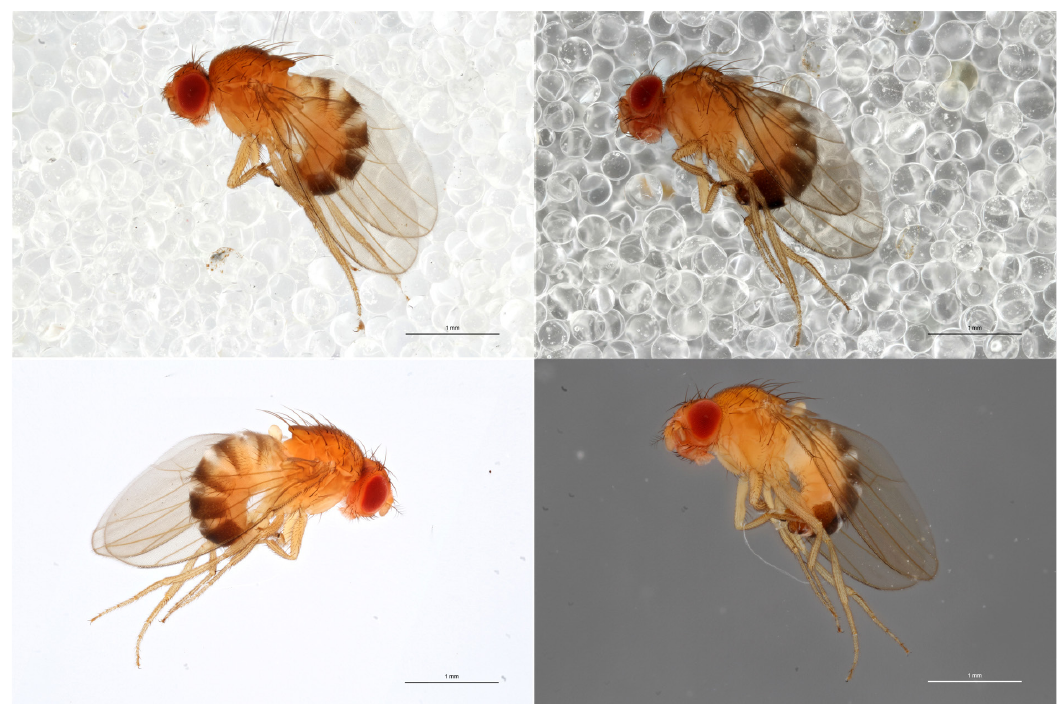
Fig. 2.9. Picturing submerged specimens. A fly of the genus Drosophila pictured in ethanol with glass beads (top pictures) or without (bottom pictures) using a white (left pictures) or grey (right pictures) background. Scale = 1 mm.